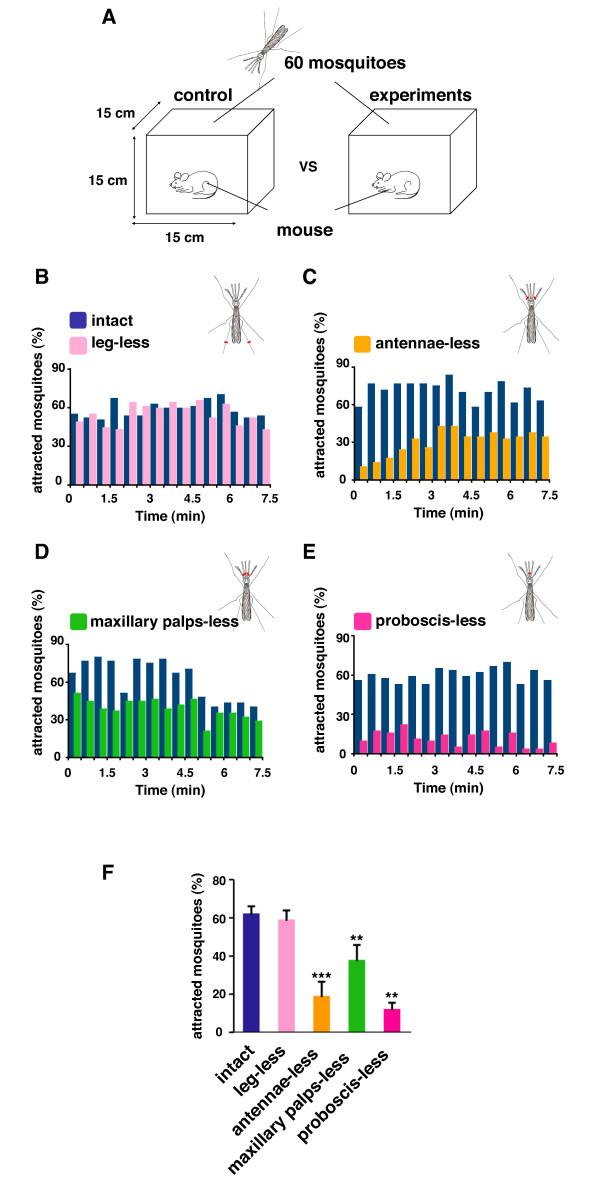
The mosquito proboscis is involved in host recognition. (A) Schematic of host recognition assay (see Materials and Methods). 120 female mosquitoes were divided into two groups, intact (control) and appendage-ablated (experiment). Mice were placed individually into indicated cages and monitored simultaneously by counting the number of mosquitoes sucking blood. (B-F) To determine the contribution of each appendage to host recognition, each group of female mosquitoes lacking specific body parts (leg, antennae, maxillary palps, or proboscis) was prepared for the assay shown in (A). The proportion of mosquitoes touching down on mice was calculated every 0.5 min for 7 min. Blue bars represent controls while other colored bars represent experimental groups. Note that a mosquito's ability to recognize a host is clearly reduced upon removal of the proboscis (E and F). (F) **p < 0.005, ***p < 0.001, t-test; mean ± SD, n = 4.